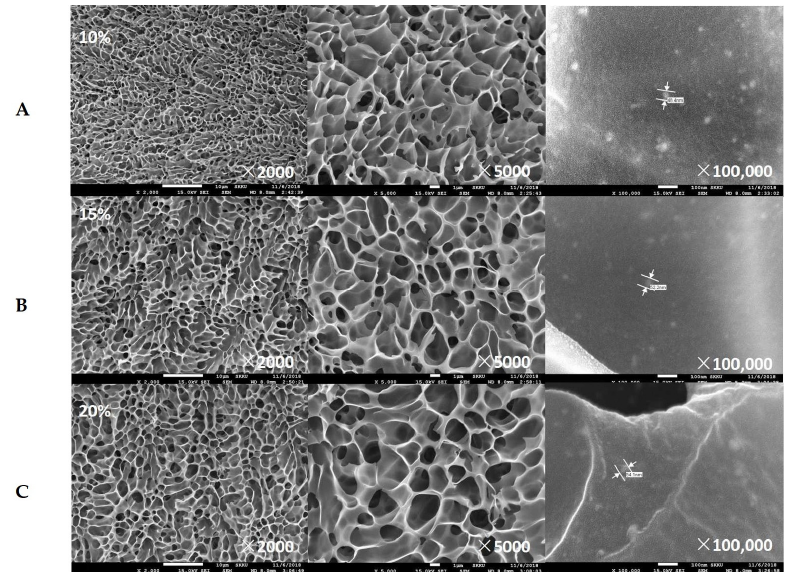
Figure 2. SEM images of freeze-dried DA-GLT 1 /AgNPs composite hydrogels with different weight contents of DA-GLT 1 (( A ): 10 wt%; ( B ): 15 wt%; and ( C ): 20 wt%) and different magnifications (2000, 5000, and 100,000).